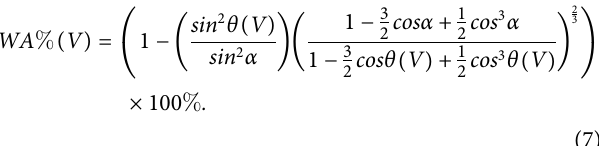
When the colored oil fi lm in a pixel splits into small droplets, the contact area between the oil and the hydrophobic insulator layer becomes larger. For example, if a single droplet with 90 ° contact angle splits into two droplets, the whole area of the √ (cid:8) times that of the original one. two oil droplets occupied is 2 3